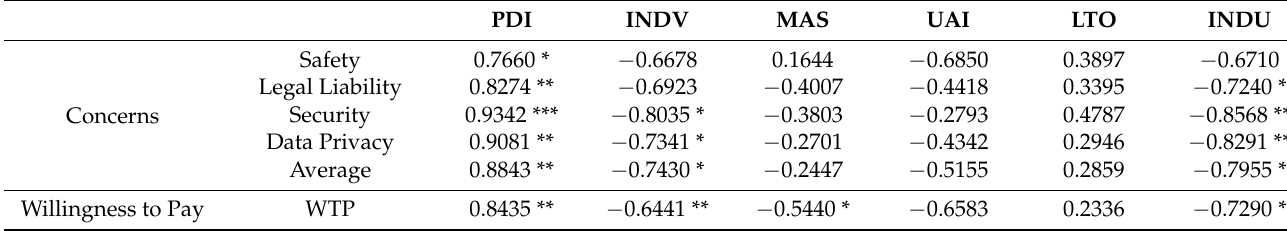
Table 3. Correlation between survey results and the 6-D